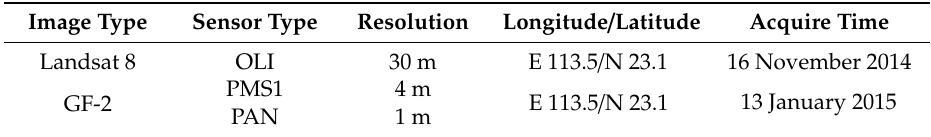
Table 1. The detail of remote sensing data.